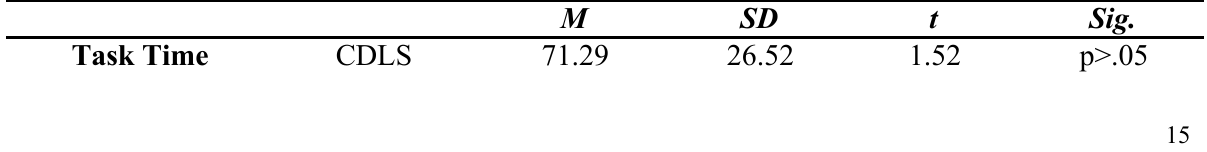
Learning Performance of